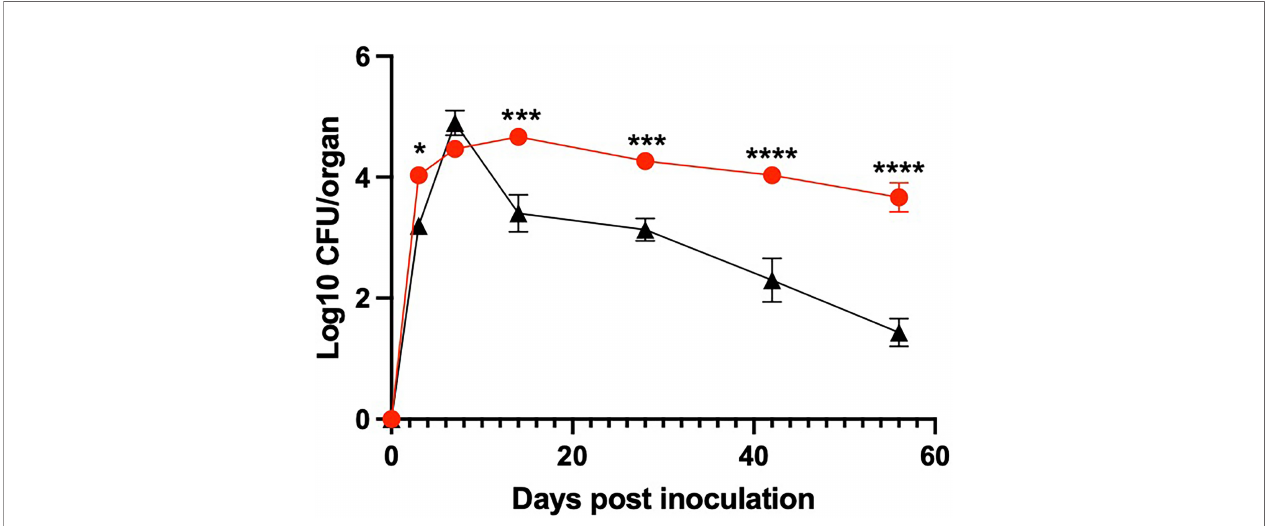
FIGURE 1 | B. pseudohinzii ef fi ciently colonizes and persists in the middle ears. Log10 of CFU recovered on days 3, 7, 14, 28, 42 and 56 post inoculation from the middle ears of mice inoculated with either B. bronchiseptica (black) or B. pseudohinzii (red) bacteria (n=4 per strain per timepoint). Error bar shows the standard error of mean. Statistical signi fi cance was calculated by using Two-way ANOVA. *p< 0.0332, ***p < 0.0002, ****p <